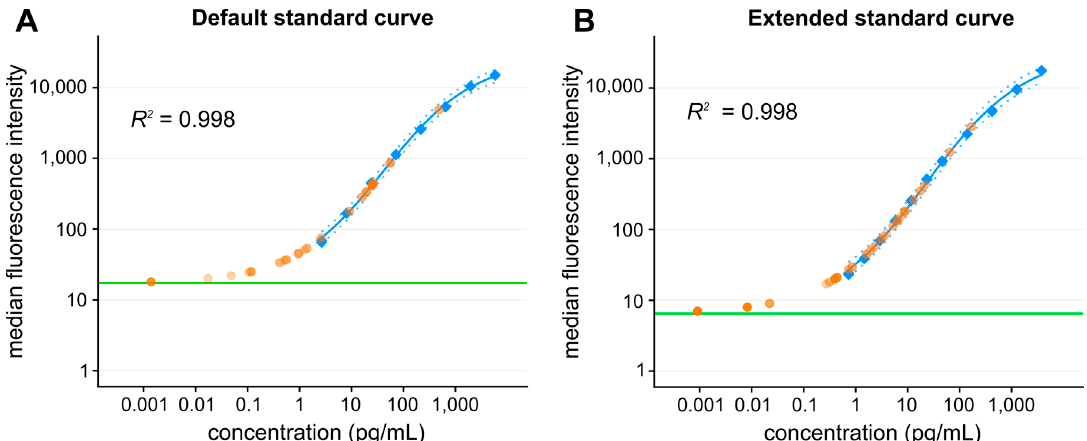
Figure 3. Optimization of standard curve to detect low amounts of IFN α by Luminex array. ( A ) Typical calibration curve covers 3–4 LOGs of cytokine concentration; ( B ) for some cytokines, additional data points at the lower end of the curve enable quantification of low cytokine concentration in samples and expansion of quantification over 4 orders of magnitude in cytokine concentration. Standard curves are calculated by drLumi package [132] in R statistical environment, full line shows standard curve fit to calibration standards (blue diamonds), dotted lines show prediction interval. Data points of real samples of experimental pig model body fluids are shown as orange circles. Three circles with the lowest IFN α concentration represent healthy control untreated animals.